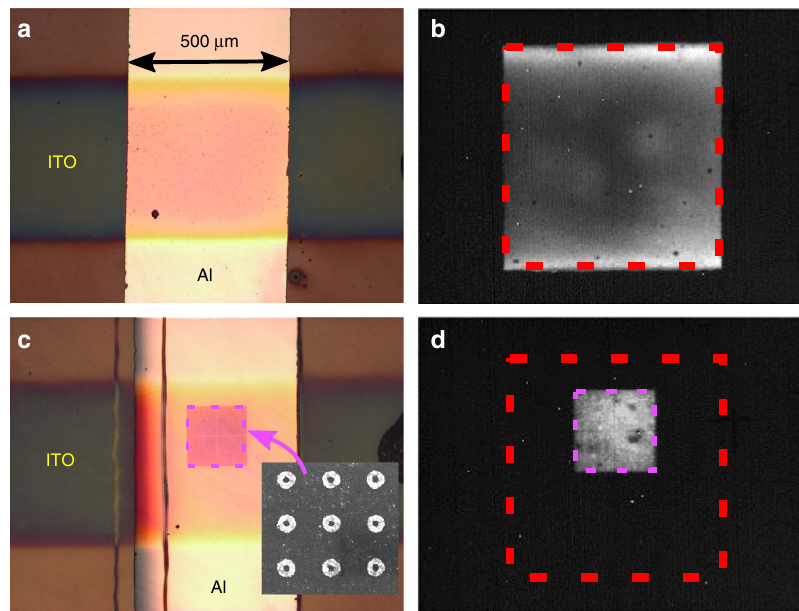
Figure 2 | Images of fabricated devices and infrared EL. ( a ) Optical image of a reference sample. The junction is defined by the overlap of the ITO and Al electrode. ( b ) Infrared EL of the same junction for a positive bias voltage of 10V (because the scale is different from a , we highlight the boundaries of the 500 (cid:2) 500 m m 2 junction with a red dashed square). ( c ) Optical image of a metamaterial LED. The gold nanoparticle array appears as a purple square (highlighted with a magenta dashed stroke). ( d ) Infrared EL of the metamaterial LED for a positive bias voltage of 4V (same scale as b